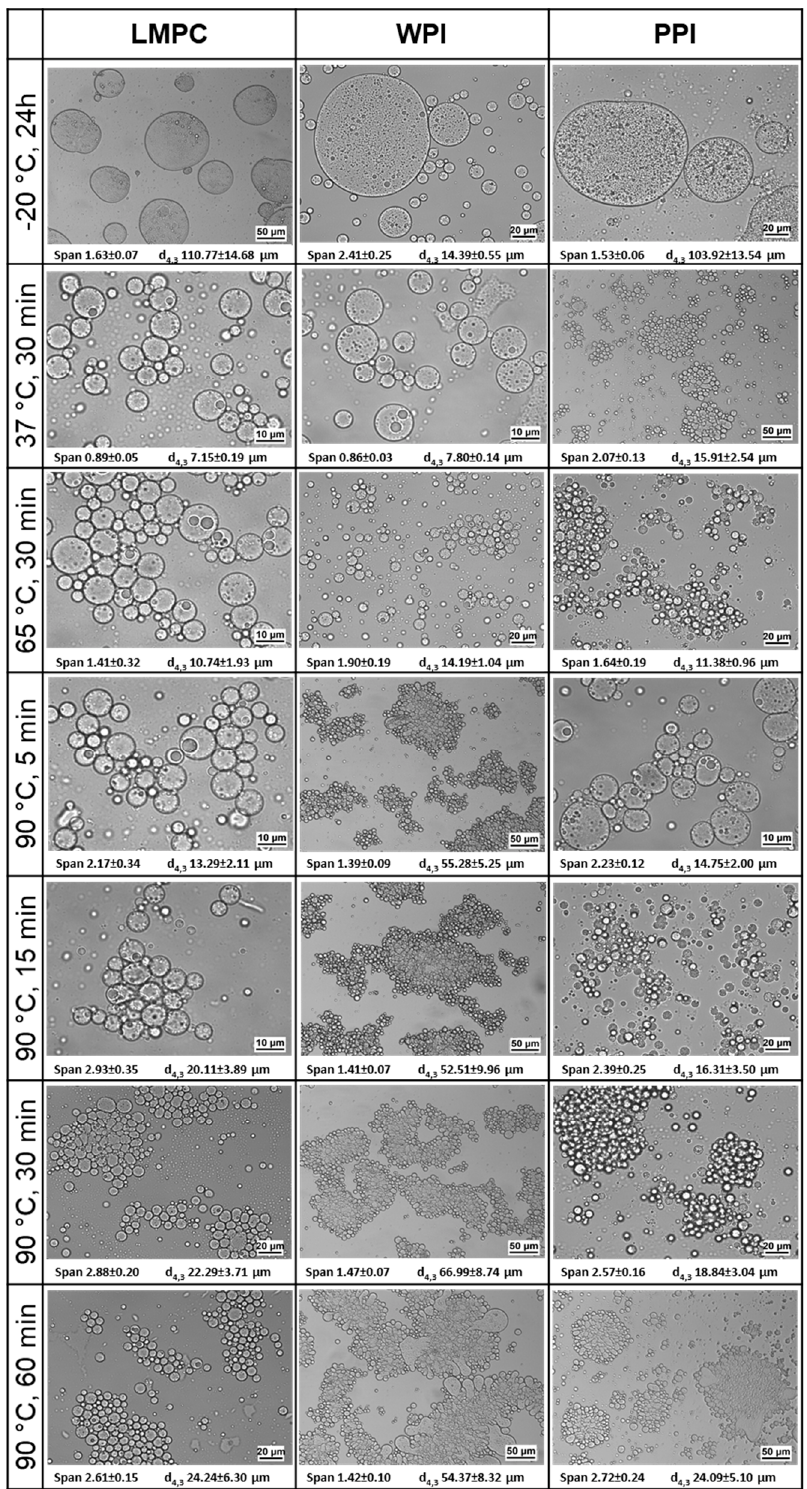
Figure 9. Microstructure of W 1 /O/W 2 emulsions stabilized with LMPC, WPI, and PPI after simulated heat storage/treatment conditions (–20, 37, 65, and 90 °C).